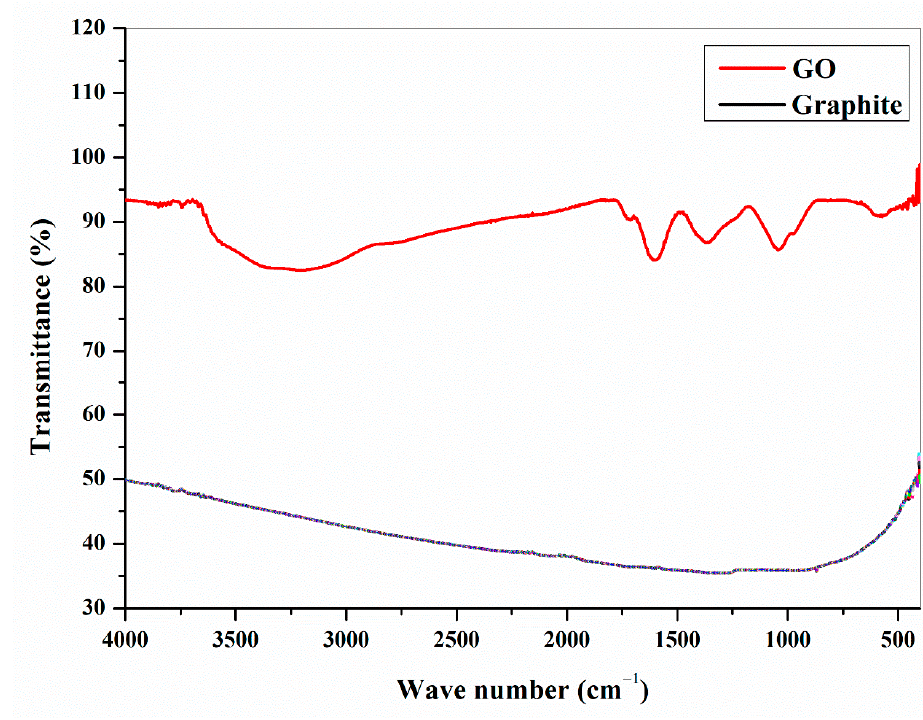
Figure 3. FTIR Fourier Transform Infra-Red spectra of prepared GO and Graphite.